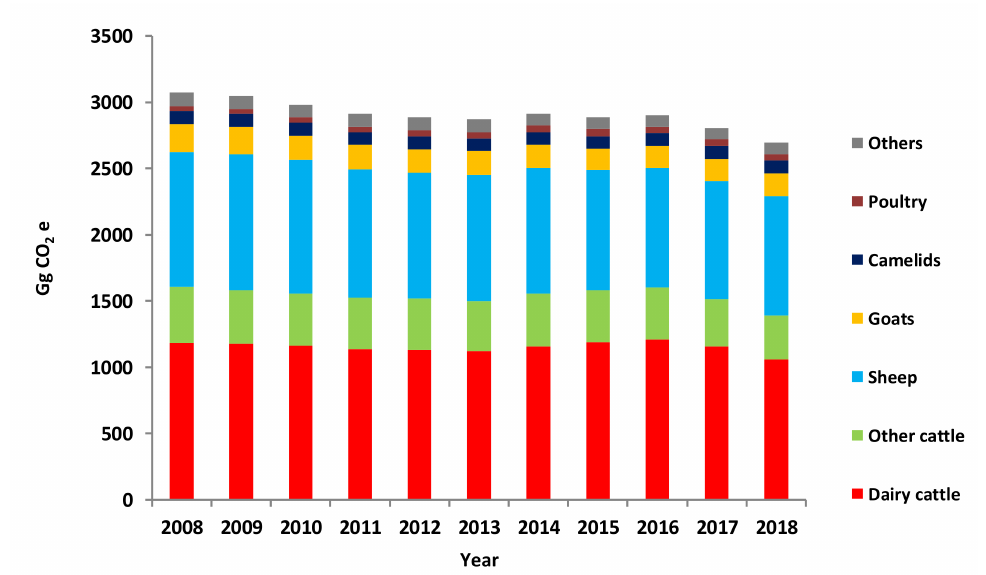
Figure 2. Evolution of the total gas emissions (Gg CO 2 e) by the di ff erent animal species / category from Tunisian livestock during the studied period